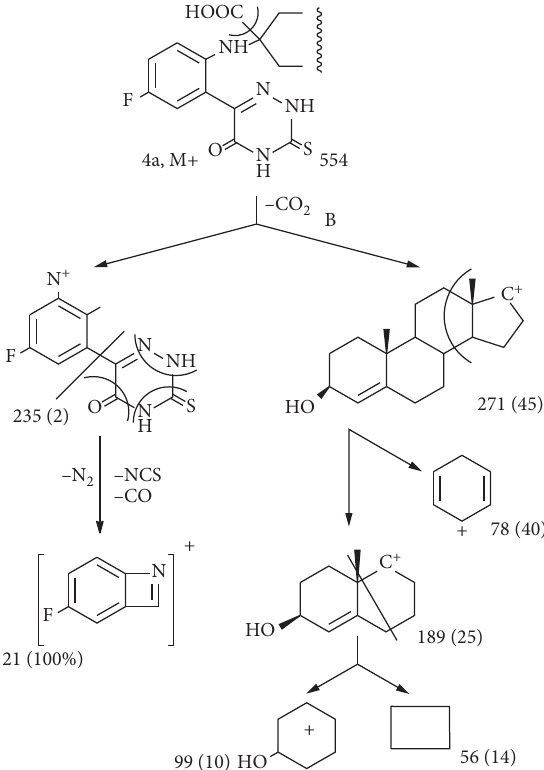
Figure 2: Proposed mass fragmentation pattern of compound 4a .